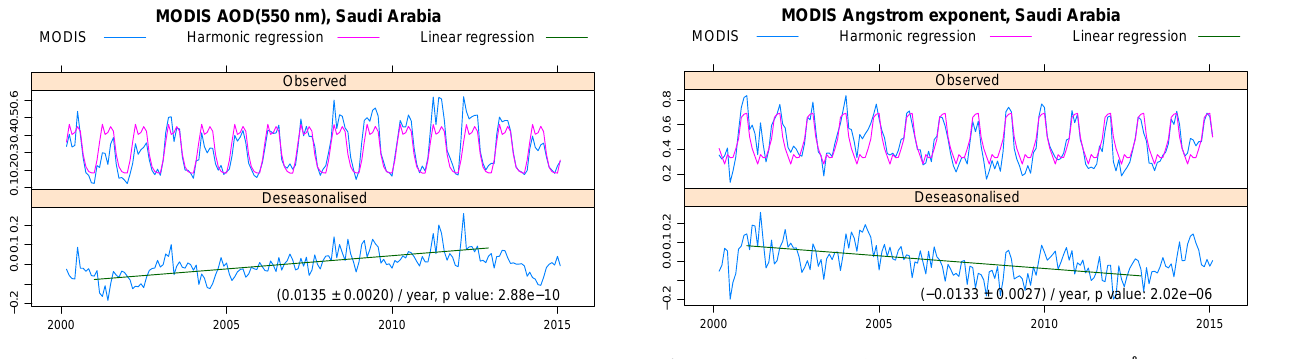
Figure 3. Evolution of the average 550nm AOD over Saudi Ara- bia from March 2000 to February 2015. Monthly values from MODIS Terra Dark Target/Deep Blue, collection 6, are shown. A seasonal cycle (pink) is obtained by harmonic regression. Sub- tracting the seasonal cycle yields the deseasonalised AOD (lower panel), the trend of which is quantified using linear regression tak- ing the 1-month lag autocorrelation of the time series into account (green). The autocorrelation structure of the time series is studied in Figs. S31 and S32 in the Supplement.